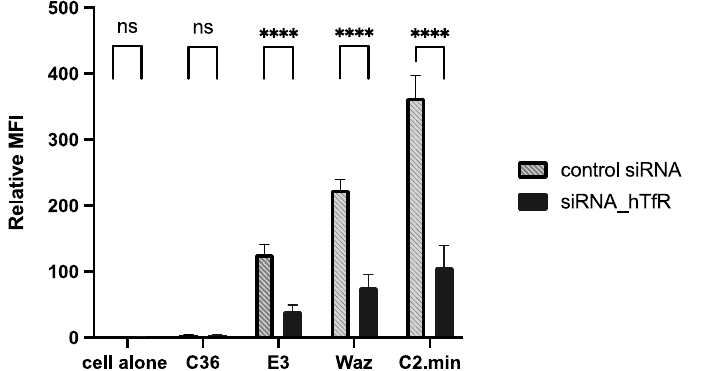
Figure 4. Analysis of binding signal after TfR knockdown via siRNA. The uptake of different aptamers was measured in Hela cells via flow cytometry at final concentrations of 200 nM. All data are normalized to the cell-alone signal. **** indicates p < 0.0001, ns = not significant, p > 0.05.